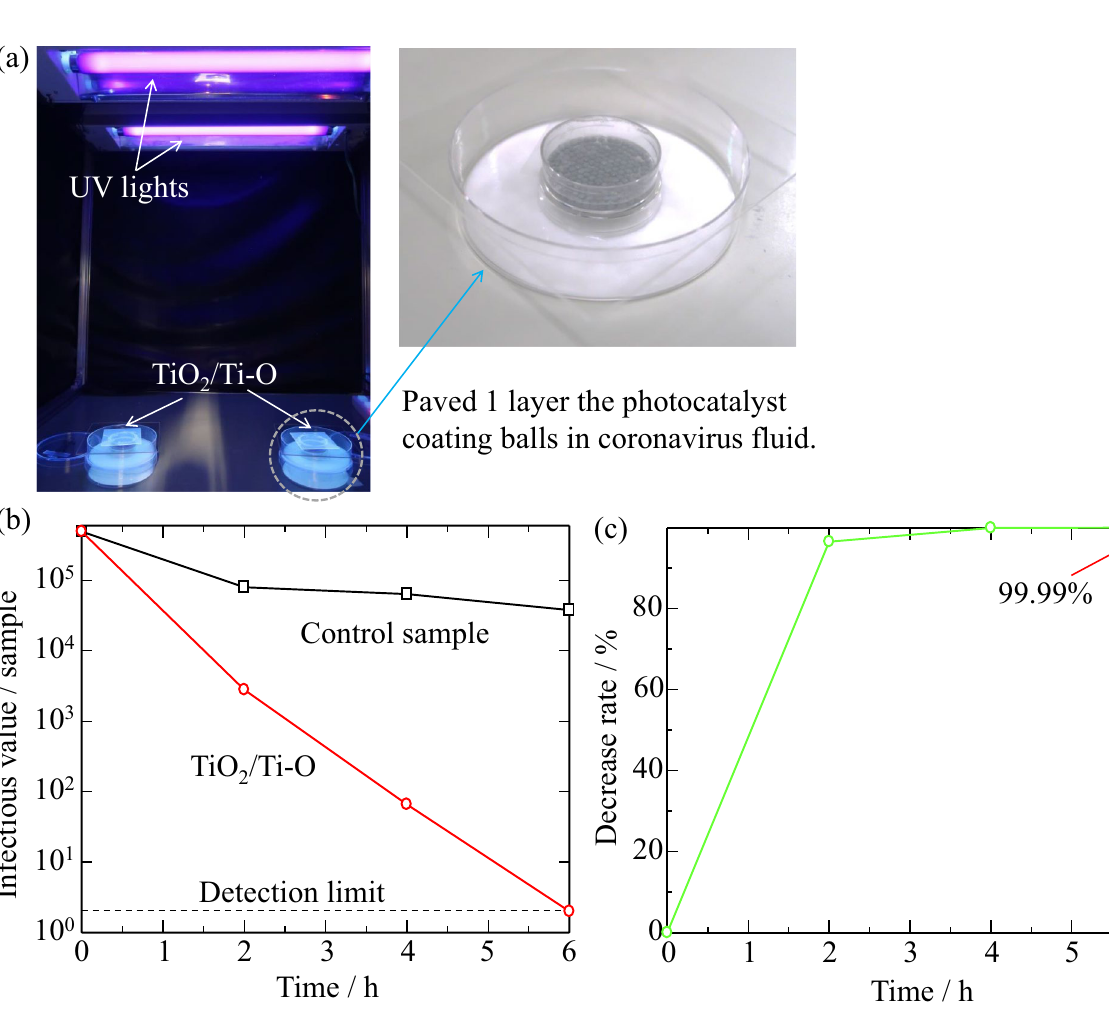
Figure 5. The inactivation test for SARS-CoV-2 of the TiO 2 /Ti–O sample. ( a ) the set-up, ( b ) the infectious value change of SARS-CoV-2, ( c ) the decrease rate of